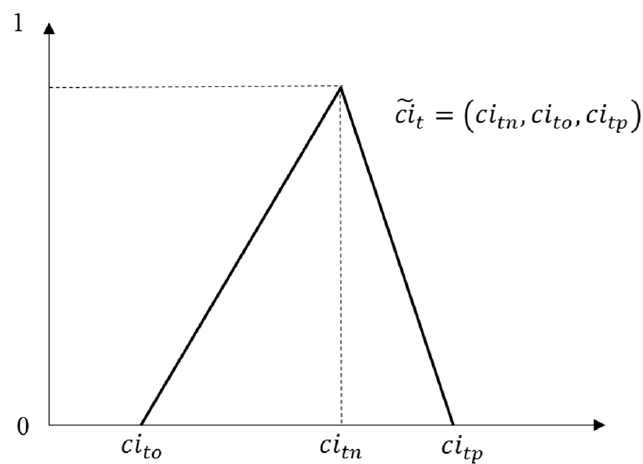
Figure 1. Triangular possibility distribution .